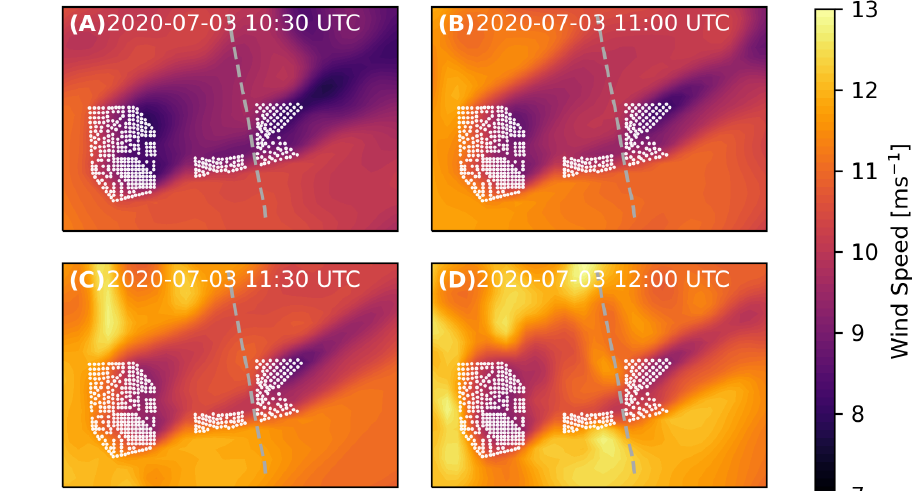
Figure 9. Spatial distribution of the modeled wind speed (see color bar) from the WRF simulation with a wind farm parameterization on 3 July 2020 at different time steps. The dashed gray line indicates the position of the flight leg shown in Fig. 8b.